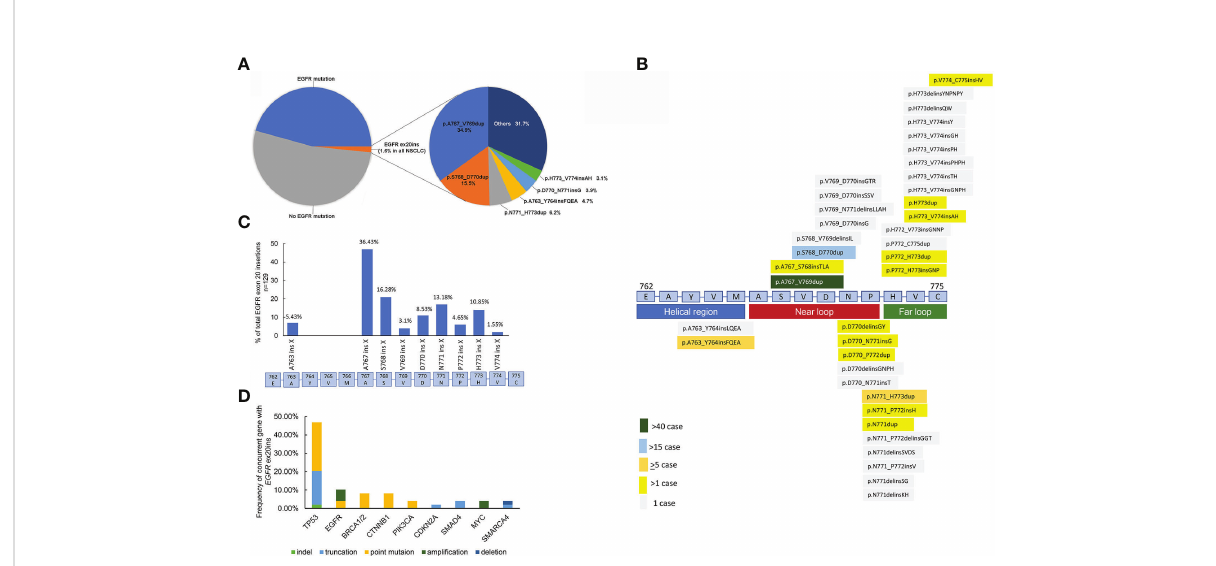
FIGURE 2 (A) Frequency of unique EGFR exon 20 insertions detected by comprehensive genomic pro fi ling. Each alteration is shown as insertion (alternative nomenclature) or frequency. (B) Schematic of genomic positions of EGFR exon 20 insertions detected by comprehensive genomic pro fi ling. (C) EGFR exon 20 insertion mutations in NSCLC. In particular, EGFR exon 20 mutations are in-frame insertions of between one and six amino acids (indicated as ins X) across a span of ~15 amino acids (E762 – C775) in exon 20. The prevalence of exon 20 insertions that occur at different amino acid positions is shown by the blue bars. (n = 129). (D) Concurrent genomic alterations with EGFR exon 20 insertions in